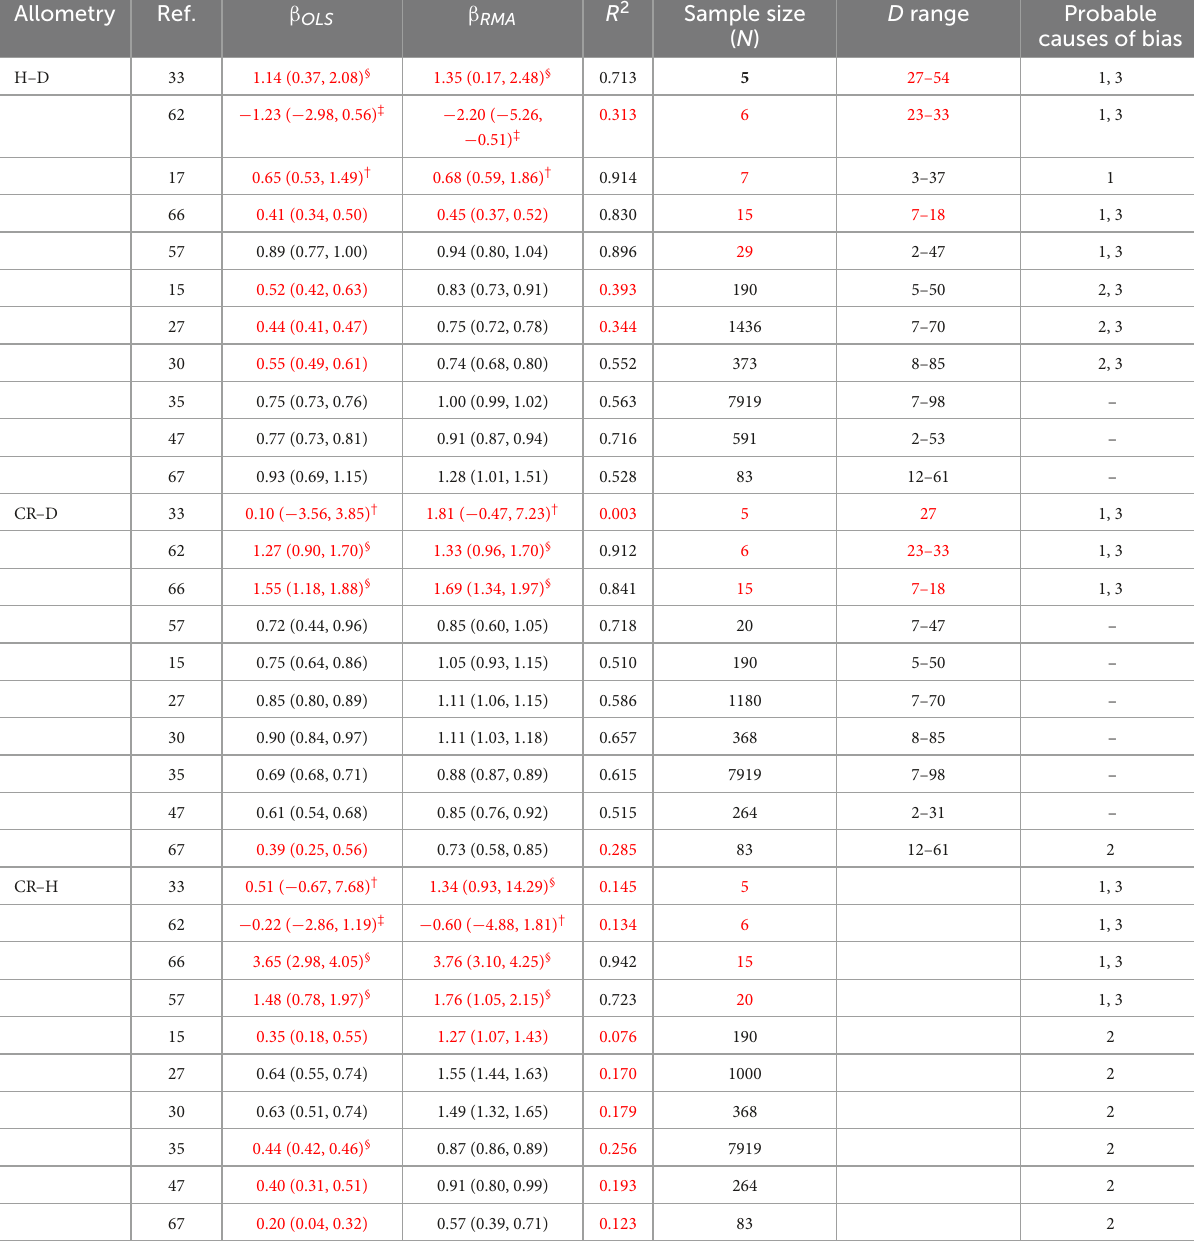
TABLE 3 Study-level variations in the OLS and RMA estimates ( β OLS and β RMA ) of the allometric scaling exponent of stem height with diameter at breast height (H–D), crown radius with diameter at breast height (CR–D) and crown radius with stem height (CR–H) of Pinus sylvestris in the temperate